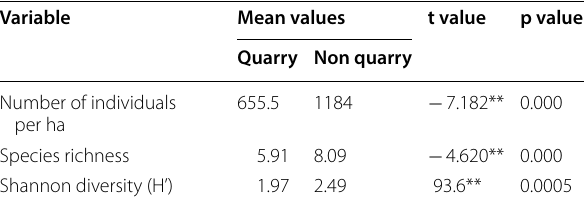
Table 4 Diversity of woody species across quarry and non- quarry